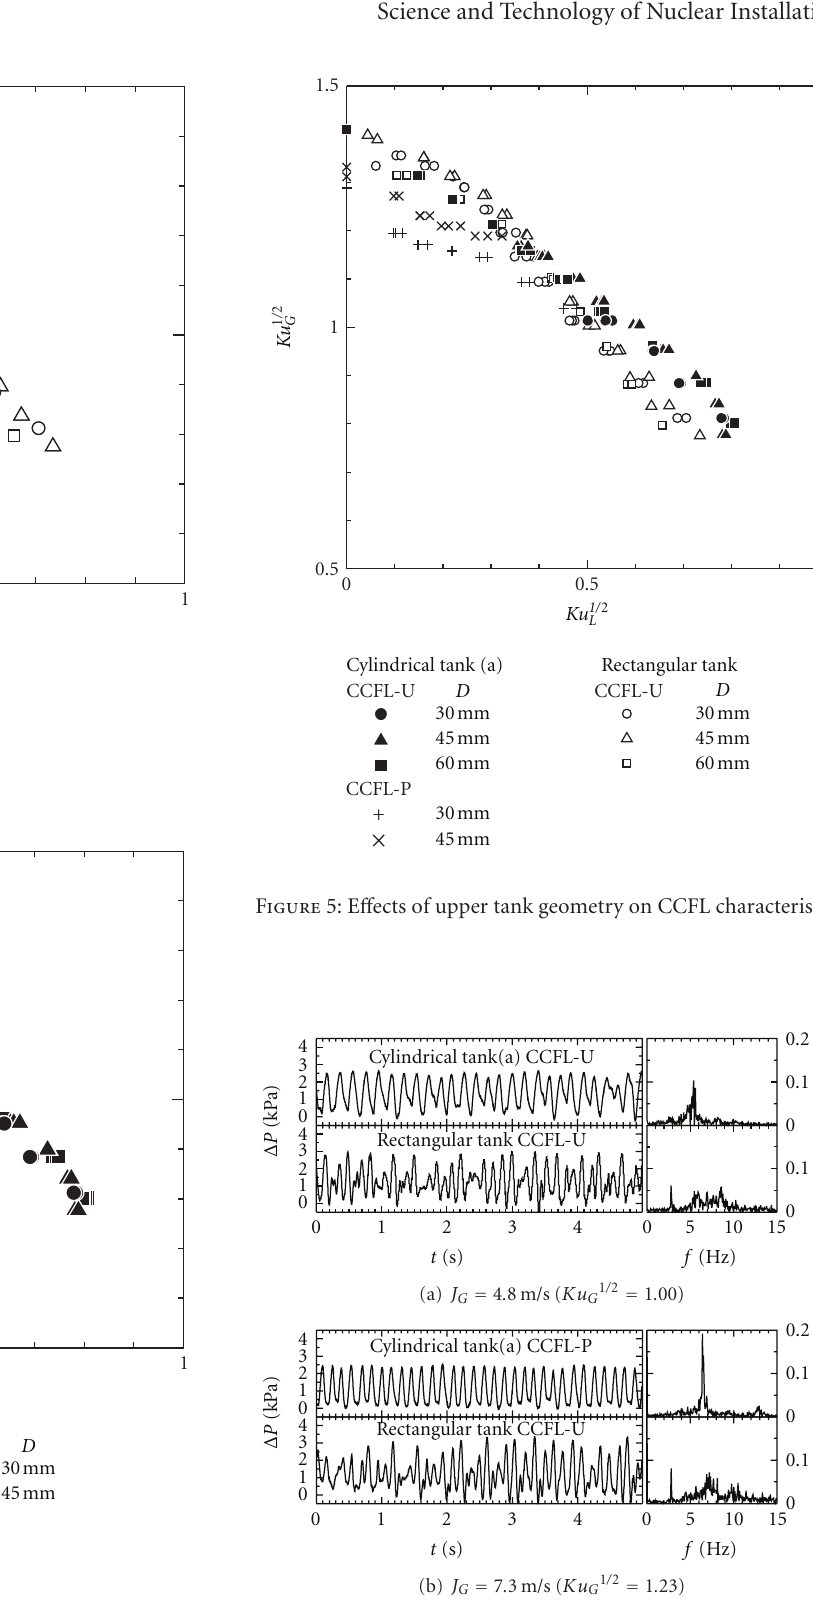
Figure 4: CCFL characteristics for rectangular and cylindrical tanks on Ku G ∗ 1 / 2 − Ku L ∗ 1 / 2 plane.